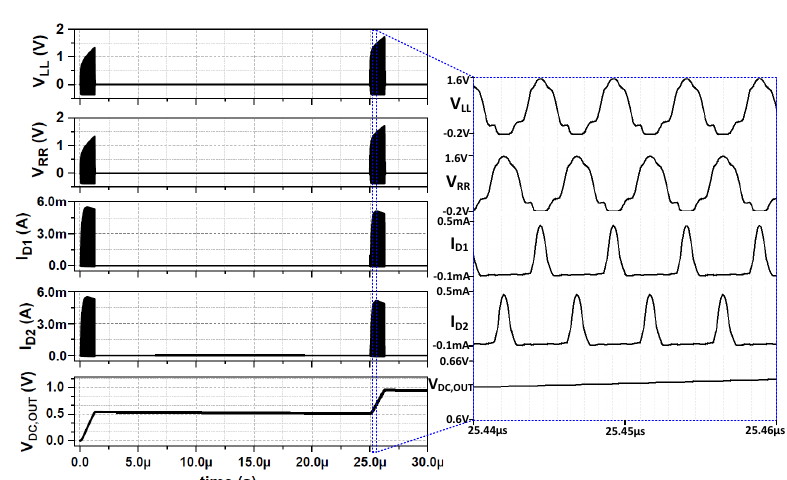
Figure 4. Circuit diagram of the rectifier used in the validation.